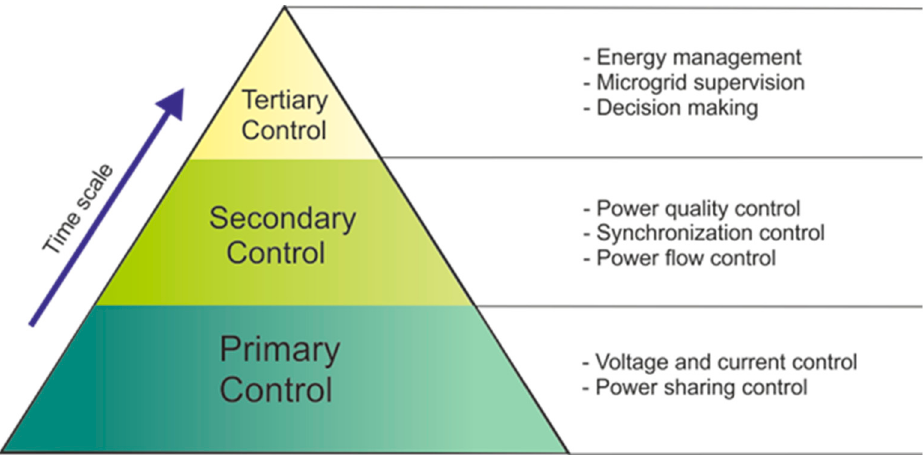
Figure 7. Scheme of the hierarchical control in a microgrid.